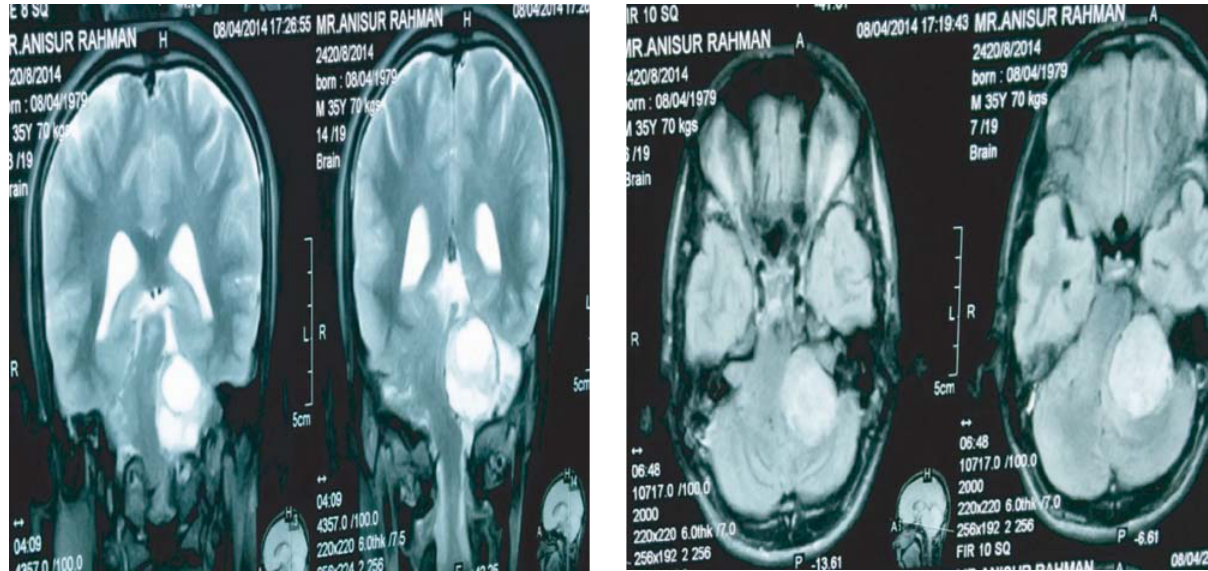
Fig 3. T2WI and FLAIR images show well defined, large heterogeneous hyperintense mass in left CP angle and also a small mass in right CP angle extending in left internal auditory meatus suggesting bilateral acoustic